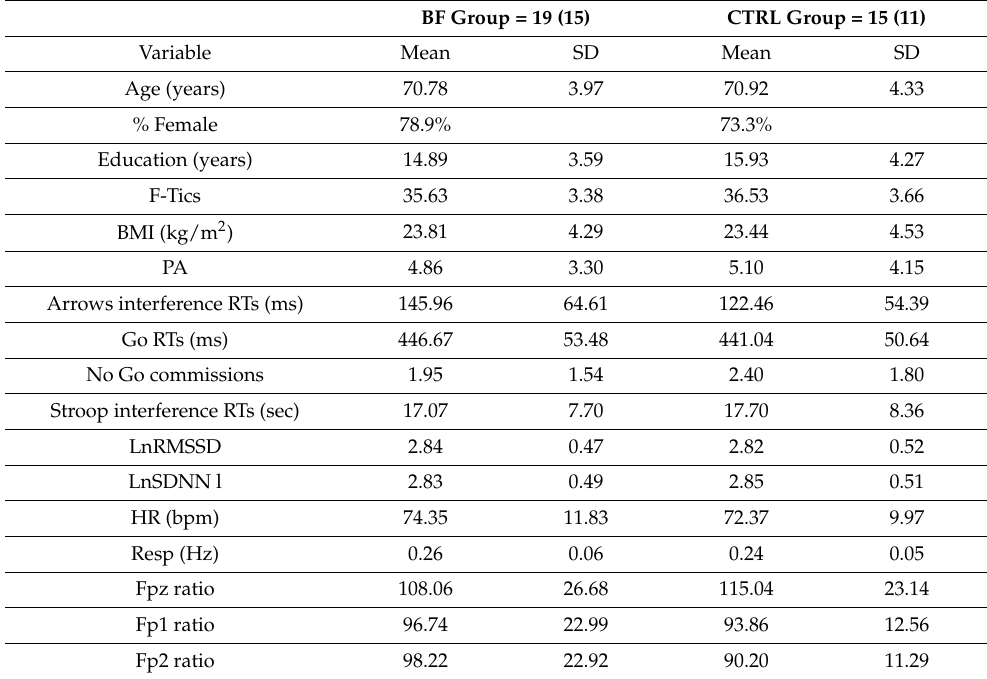
Table 1. Descriptive statistics of demographic, cognitive, and physiological measures for each group at baseline.